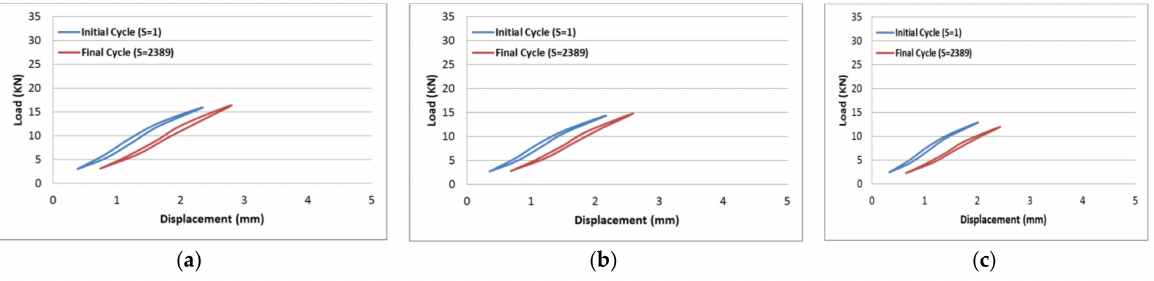
Figure 8. Load-displacement performance at 50% of the maximum load for fibre volume fraction ( a ) 50% glass fibre-reinforced polyester, ( b ) 35% glass fibre-reinforced polyester, and ( c ) 20% glass fibre-reinforced polyester.